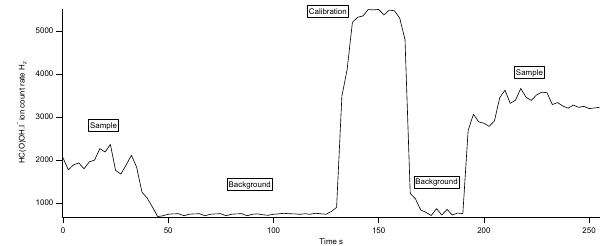
Fig. 3. Typical cycle for background, sampling and calibrations dur- ing